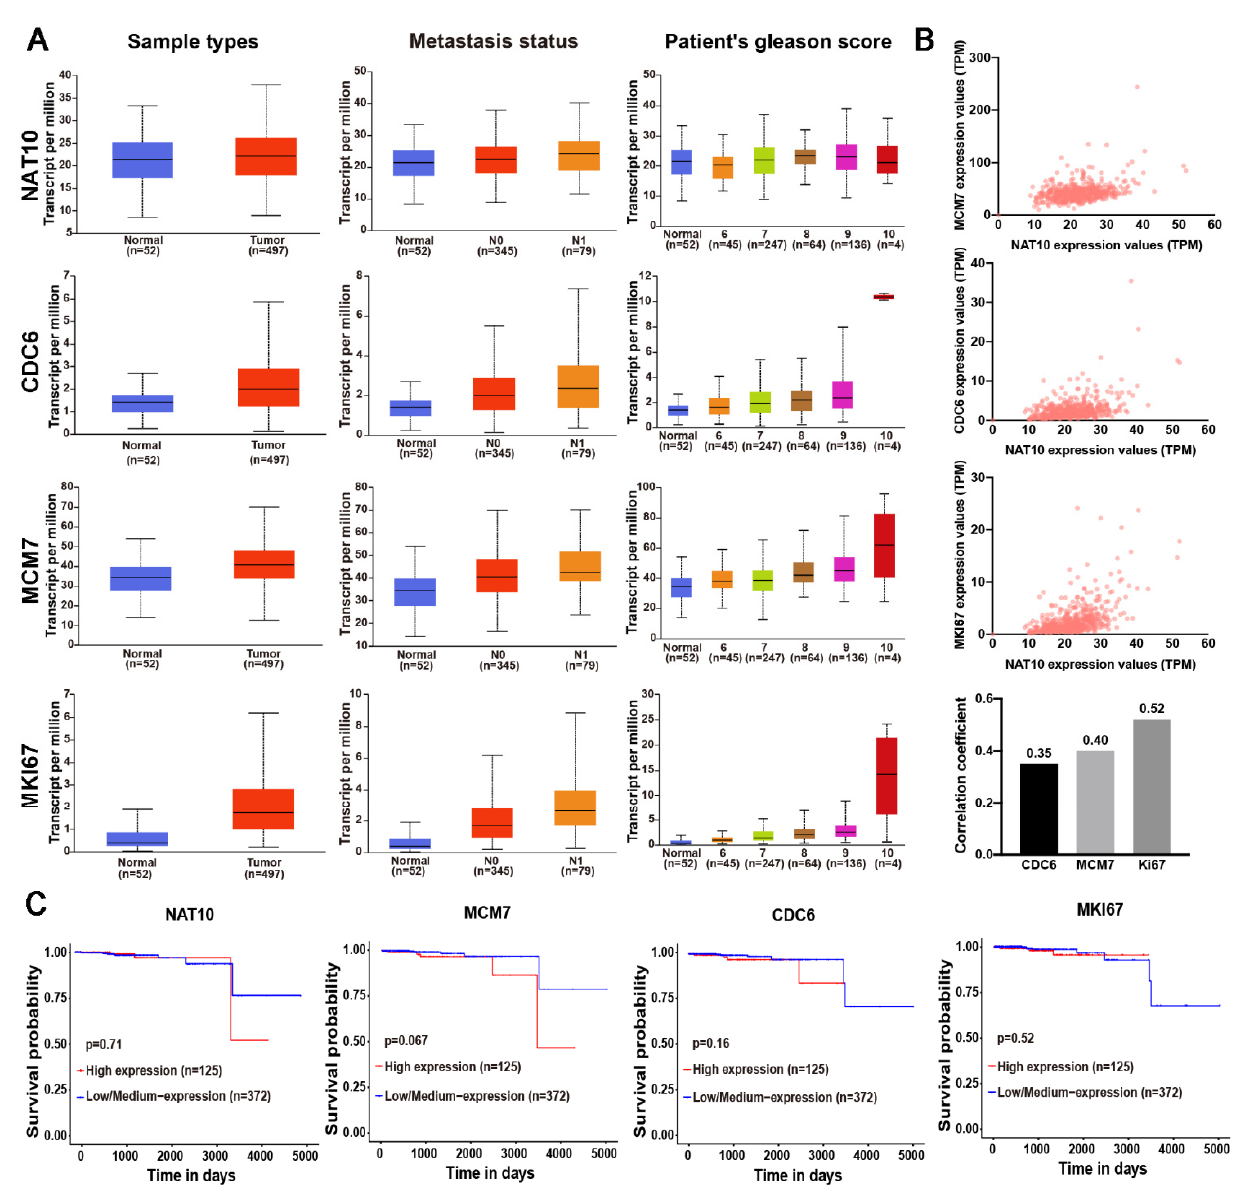
Figure 6. Correlations between NAT10 expression, and clinicopathological features of prostate cancers. ( A ) Box-whisker plots showing the expression of NAT10, CDC6, MCM7, and MKI67 in subgroups of prostate adenocarcinoma samples (PRAD). Left column, boxplot showing relative expression of protein in normal and PRAD samples. Middle column, boxplot showing relative expression of protein in normal and metastasis status. Right column, boxplot showing relative expression of protein in normal samples and samples with different Gleason scores. ( B ) Genes positively correlated with NAT10 in PRAD. Gene expression correlation between NAT10 and CDC6, and MCM7, MKI67 in prostate cancer (r ≥ 0.8, very strong correlation; 0.6–0.8, strong correlation; 0.4–0.6, moderate correlation; 0.2–0.4, weak correlation; <0.2, very weak correlation or no correlation). ( C ) Effect of protein expression level on PRAD patient survival. All data are from TCGA database and were analyzed using the UALCAN